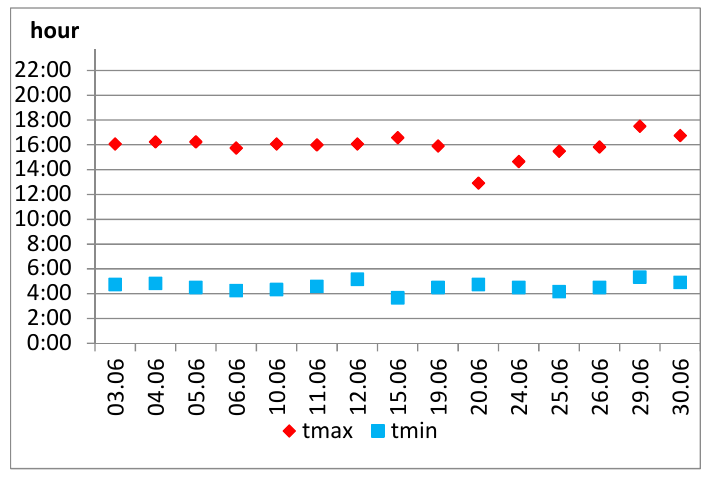
Figure 4. Hours of occurrence of the minimum and maximum air temperature values in Bydgoszcz on hot days in June 2019. Table 5. mean values and standard deviation: UTCI, STI, Oh_H, SW, and OV meaured in Bydgoszcz on hot days in June 2019.